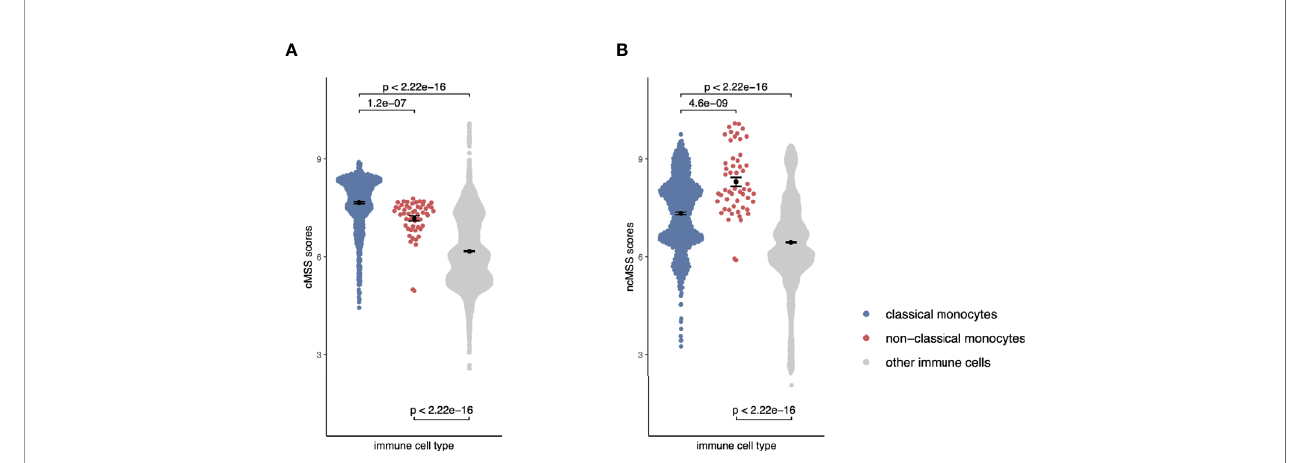
FIGURE 4 | Monocyte signatures are speci fi c across all immune cells: (A) Beeswarm plots displaying cMSS scores across 6160 transcriptomes pro fi ling sorted human immune cells. Colors indicate whether a sample is a classical, non-classical monocyte, or any other immune cell. P-values were computed by t-test. (B) Same as (A) with respect to